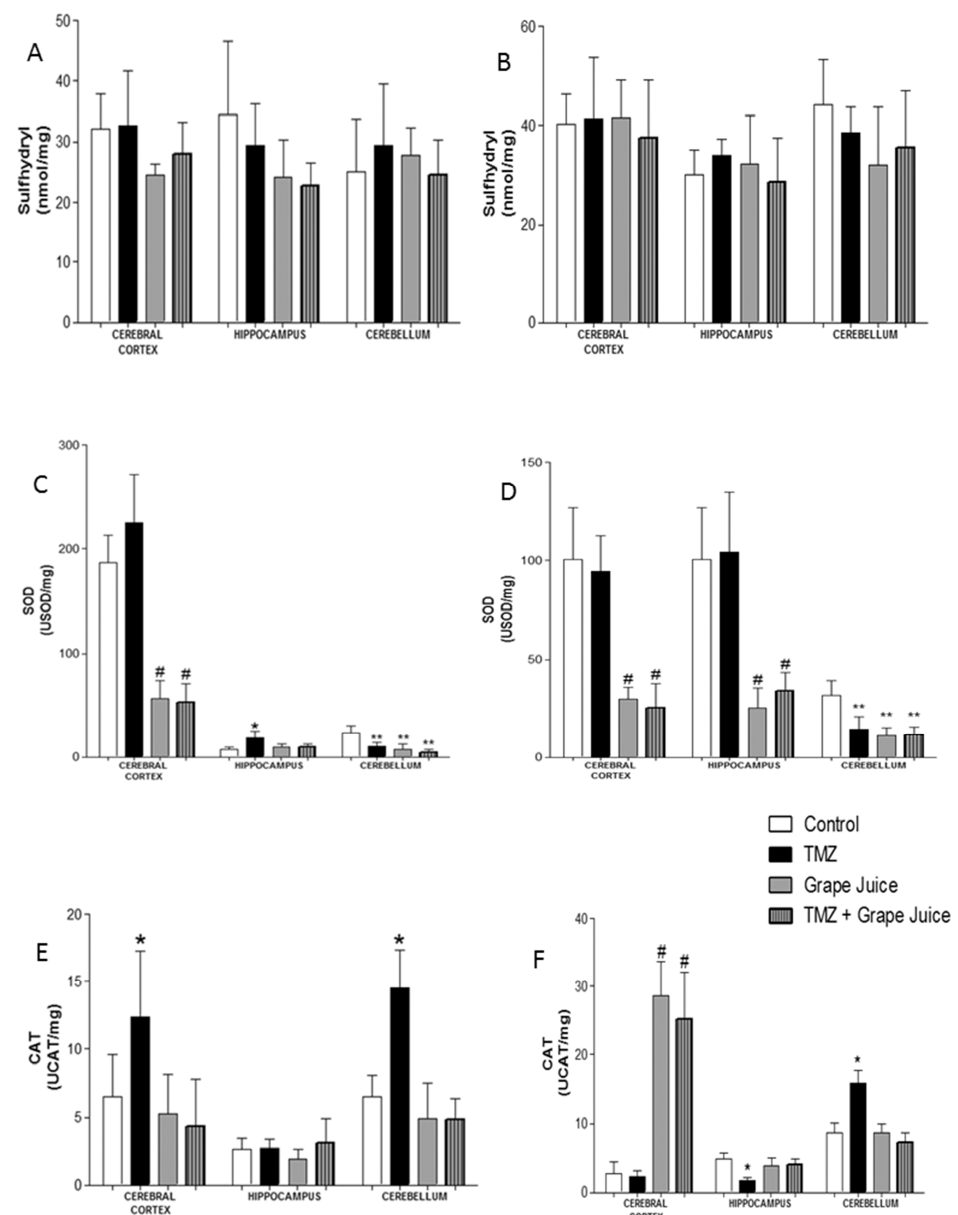
Figure 2. Effect of TMZ and pre-incubation with purple grape juice on sulfhydryl groups ( A ), superoxide dismutase (SOD) activity ( C ) and catalase (CAT) activity ( E ) and effect of co-incubation with TMZ and purple grape juice on sulfhydryl groups ( B ), superoxide dismutase (SOD) activity ( D ) and catalase (CAT) activity ( F ) in the cerebral cortex, hippocampus and cerebellum of rats. Data are expressed as mean ± standard deviation. * p < 0.05 from other groups; ** p < 0.05 from control; # p < 0.05 from control and TMZ. N = 8–10 animals/group.